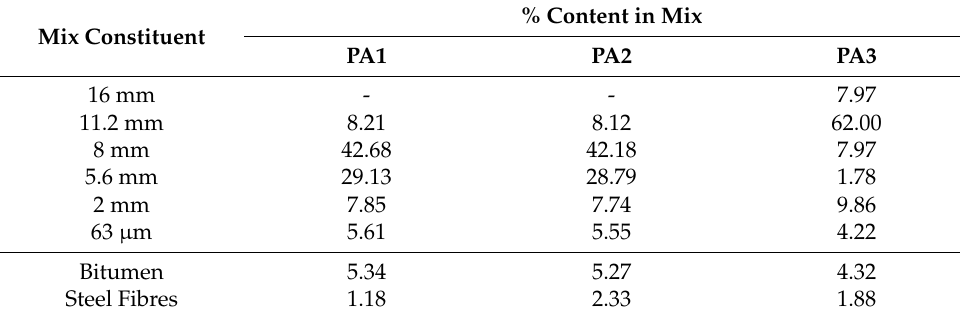
Table 1. The mix compositions of the asphalt mixture.